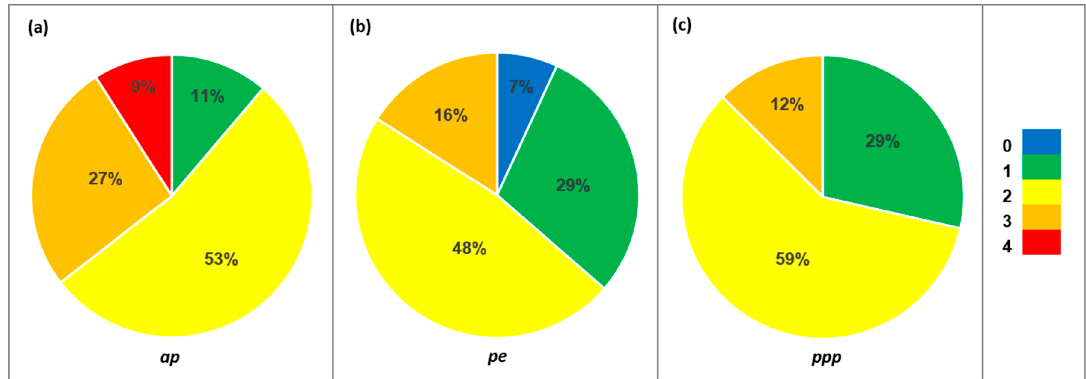
Figure 2. Percentage of plant individuals ( N = 231) in the urban park Hofgarten classified according to their ( a ) allergenic potential (ap); ( b ) type of pollen emission (pe) and ( c ) duration of principal pollination period (ppp, see Table 2 for parameters and values).